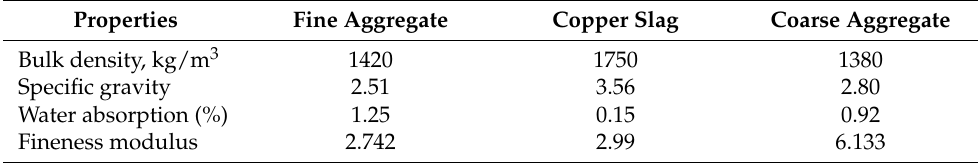
Table 1. Properties of